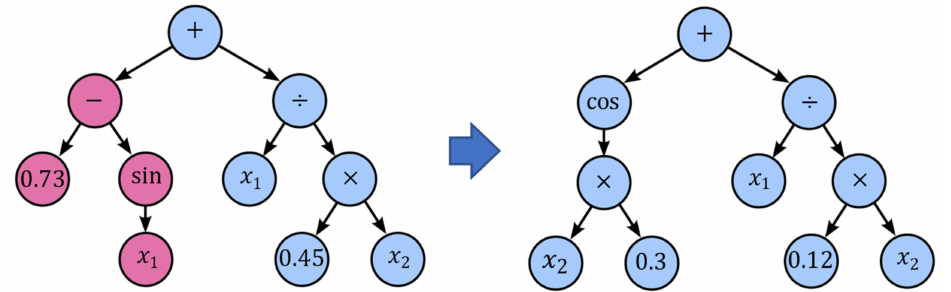
Figure 12. Subtree mutation.